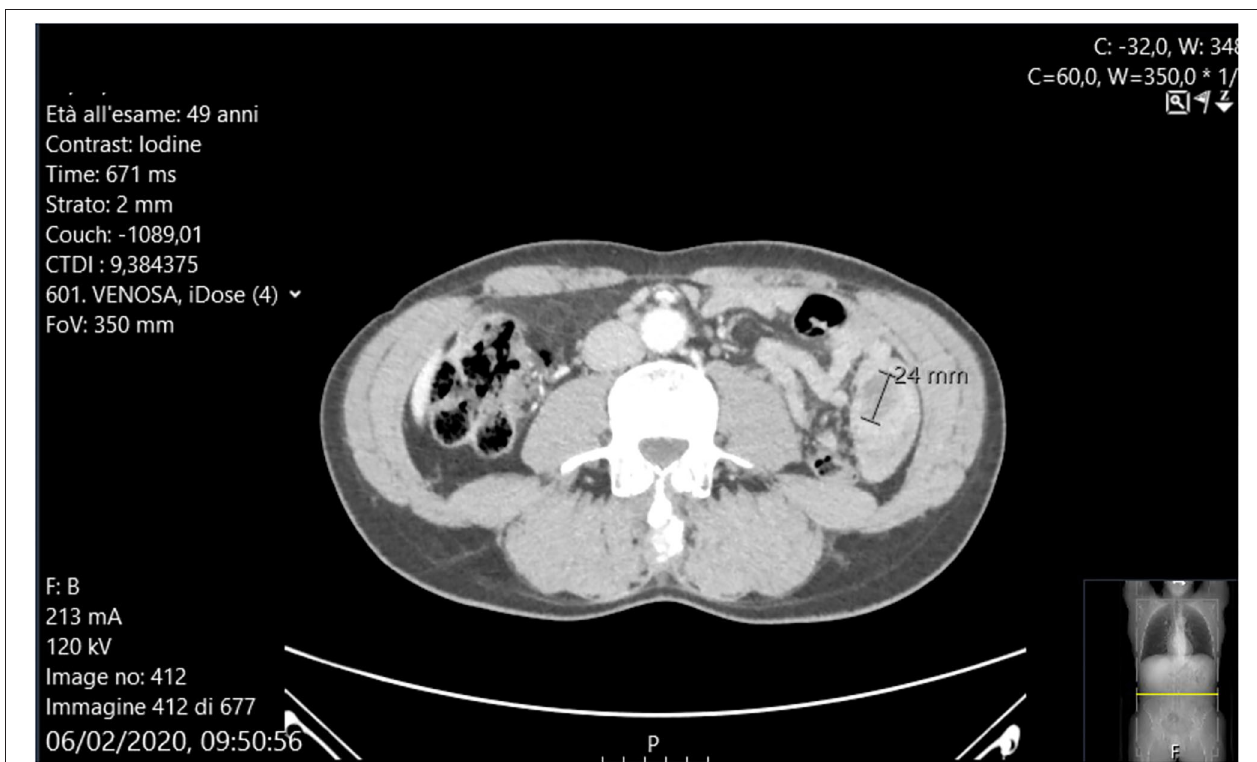
FIGURE 1 | Ct-scan showing the invaginated tract containing a 24 mm